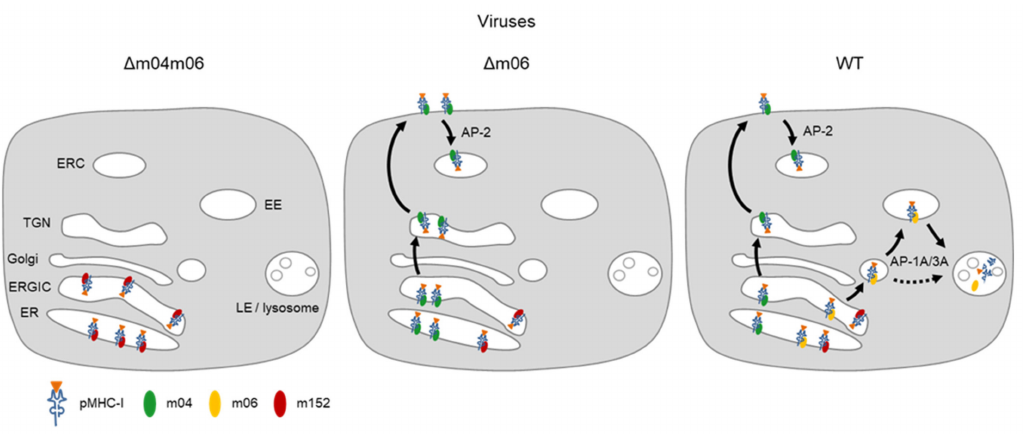
Figure 5. Graphical abstracts explaining agonistic and antagonistic vRAP functions. (ER), endoplas- mic reticulum; (ERGIC), ER Golgi-intermediate compartment; (TGN), trans-Golgi network; (ERC), endosomal recycling compartment. Note that an early gene function of mCMV blocks cargo recycling from the ERC to the cell surface [103]; (EE), early endosome; (LE), Late endosome; AP, cellular adapter protein. Solid arrows indicate main pathways; the dashed arrow indicates an alternative